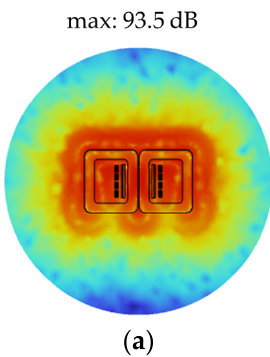
Figure 15. Sound pressure level distribution diagram under normal condition ( a ) Interleaved winding; ( b ) Continuous winding.